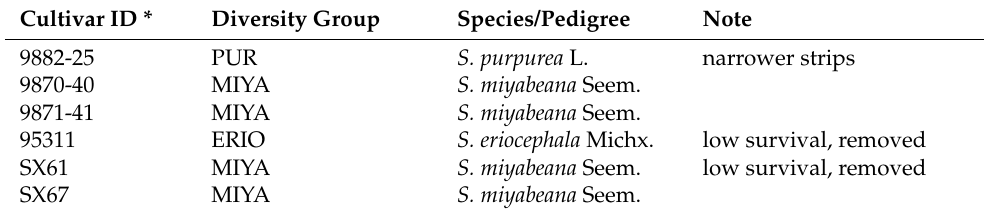
Table 1. Shrub willow cultivars included in the time of harvest study in Canastota, NY. The trial originally had 6 cultivars, but two were removed after the first harvest due to low survival. Cultivar ID * Diversity Group Species/Pedigree